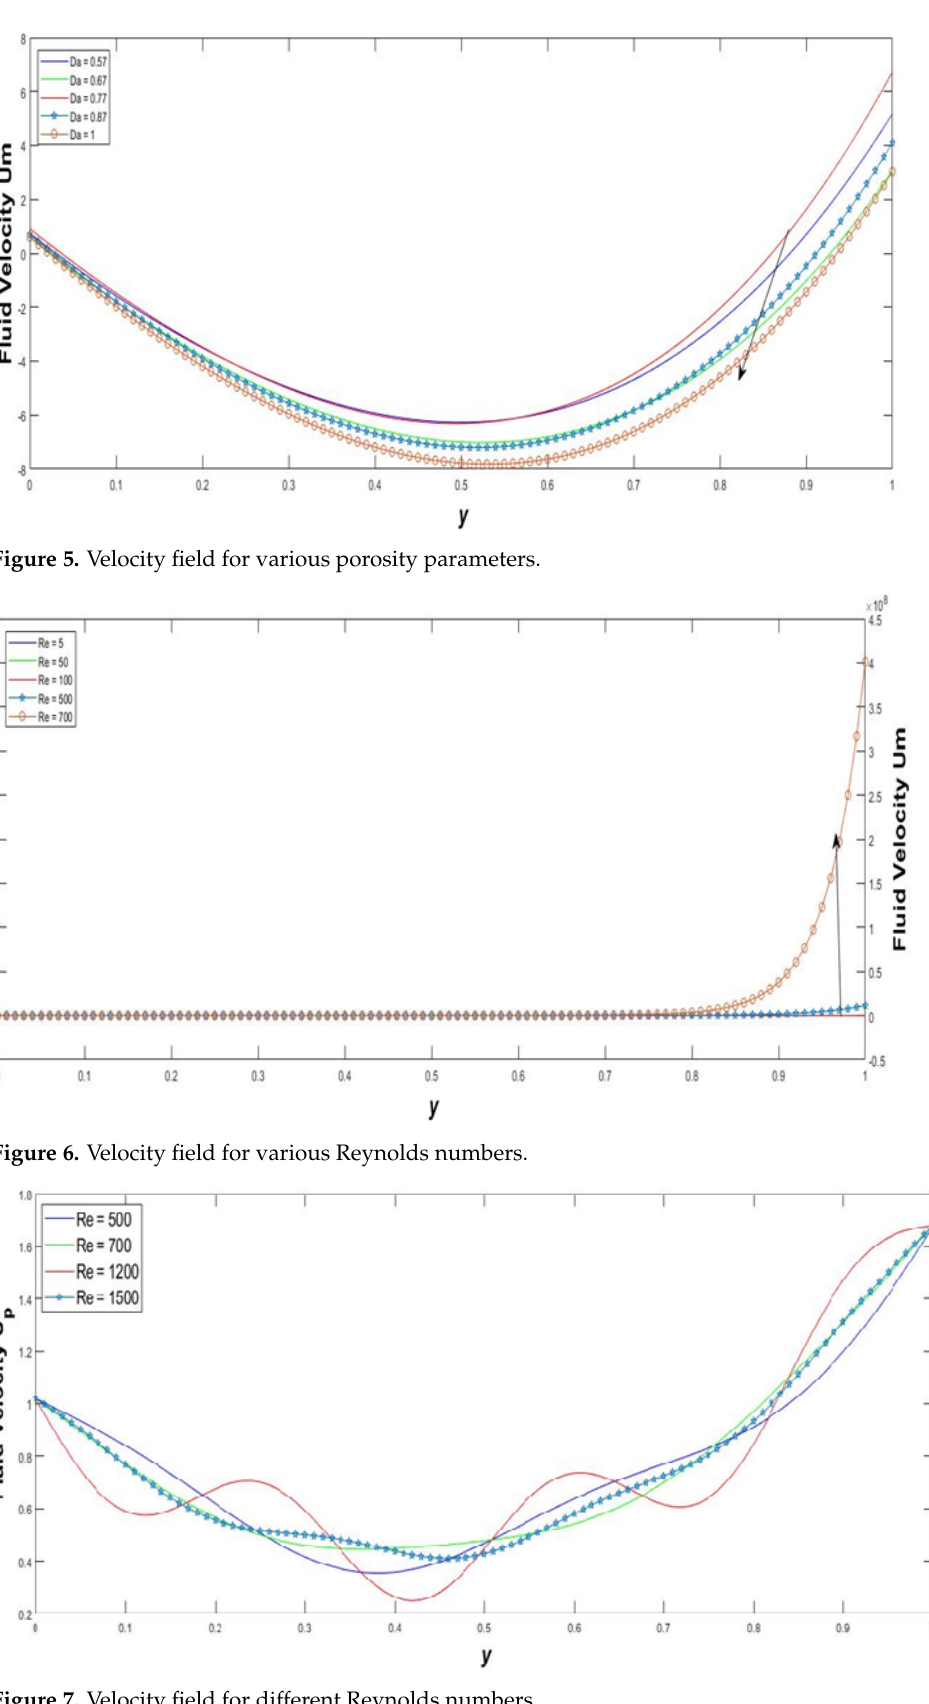
Figure 7. Velocity field for different Reynolds